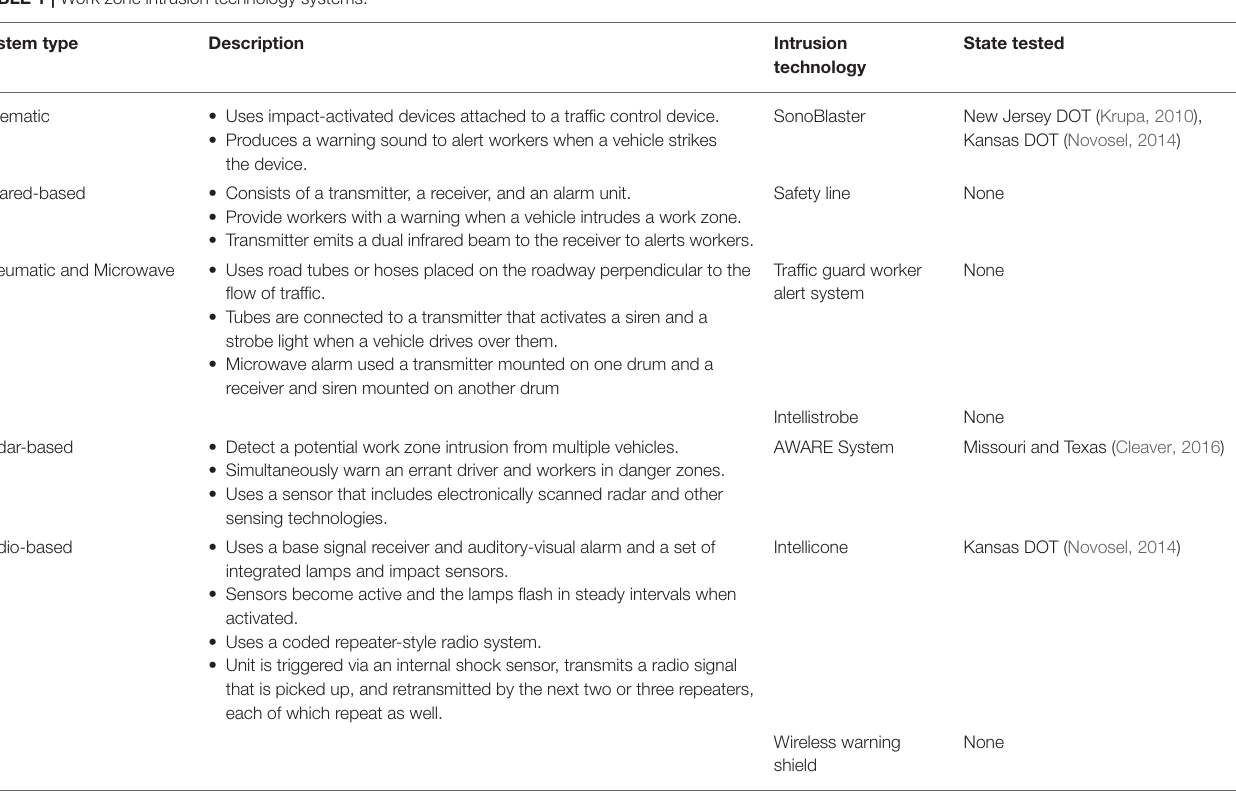
TABLE 1 | Work zone intrusion technology